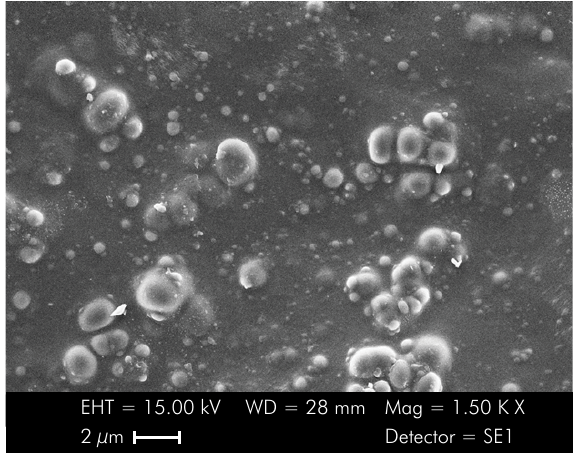
Figure 4. Scanning electron microscopy image of buccal film Z4 impregnated with zolpidem-loaded nanospheres.